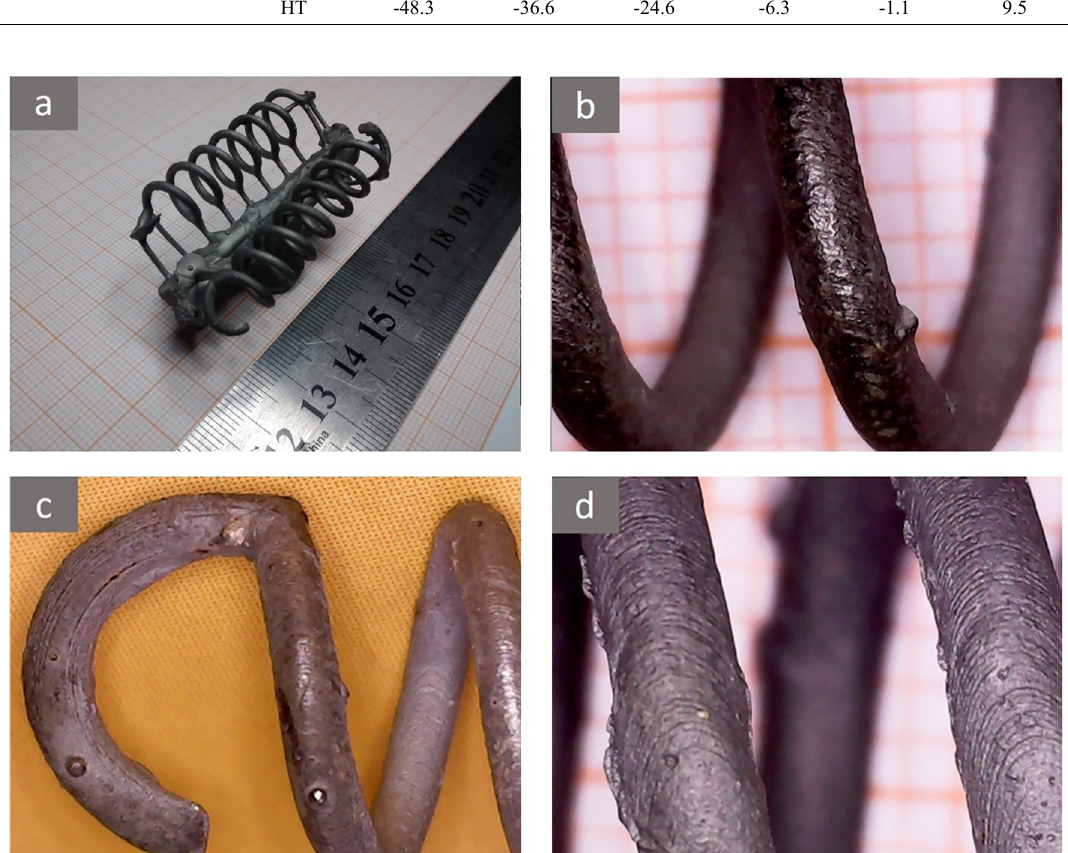
Figure 4. Some images of the Ni-Ti SMA springs manufactured by investment casting. a) SPG-D1.5. b) SPG-D1.0. c) SPG-D1.5. d) SPG-D2.0.